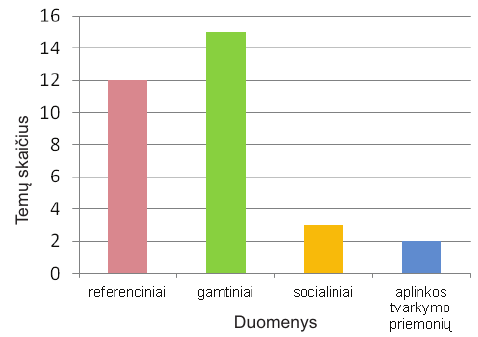
Fig. 4. Distribution of spatial data themes considering data